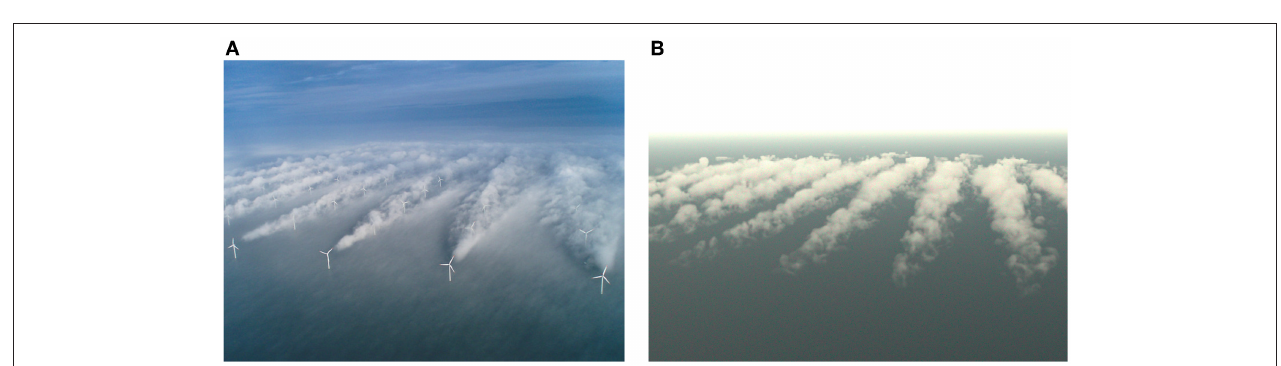
FIGURE 12 | (A) Photograph of the Horns Rev 1 wind farm (12/02/2008 around 10:10 UTC) from south (Hasager et al., 2013). Courtesy Vattenfall. Photographer: Christian Steiness. (B) Post-processing (see Villefranque et al., 2019) of simulated cloud mixing ratio. Wind turbines are not represented.